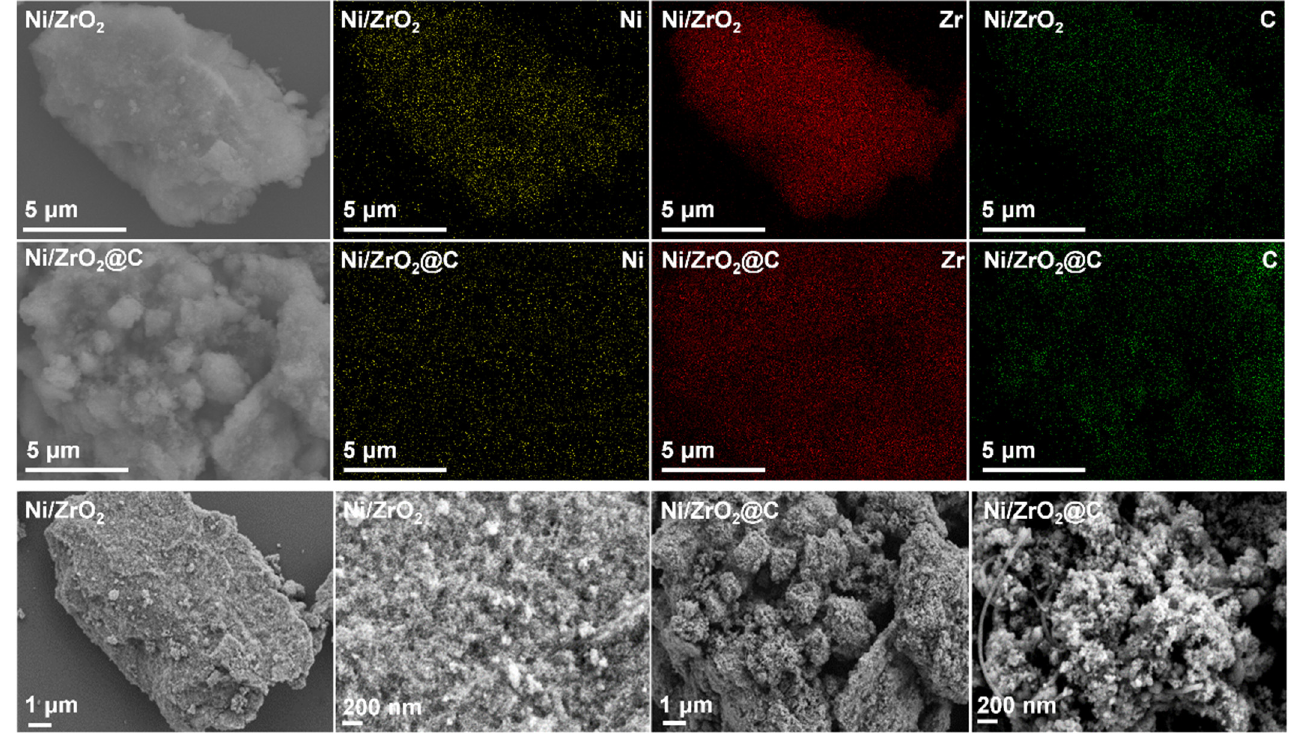
Figure 3. SEM images with elemental color mapping of Ni/ZrO 2 and Ni/ZrO 2 @C. Furthermore, the color mapping analysis showed that the carbon element was homo- geneously distributed on Ni/ZrO 2 , thus confirming that it indeed originated from the sample, which was consistent with the above XPS observation. On the other hand, the carbon distri- bution was not as homogeneous as Ni or Zr on Ni/ZrO 2 @C. The C intensity was stronger on the rough surfaces, suggesting that these rough ensembles were likely the carbonaceous materials newly formed by the reforming reaction. Indeed, a close exami- nation of the SEM images confirmed the fragmentation of the samples, as well as the pres- ence of some tube-like carbon deposits. These clear morphology differences were further confirmed by TEM (Figure 4). Small nickel nanoparticles deposited on ZrO 2 were found